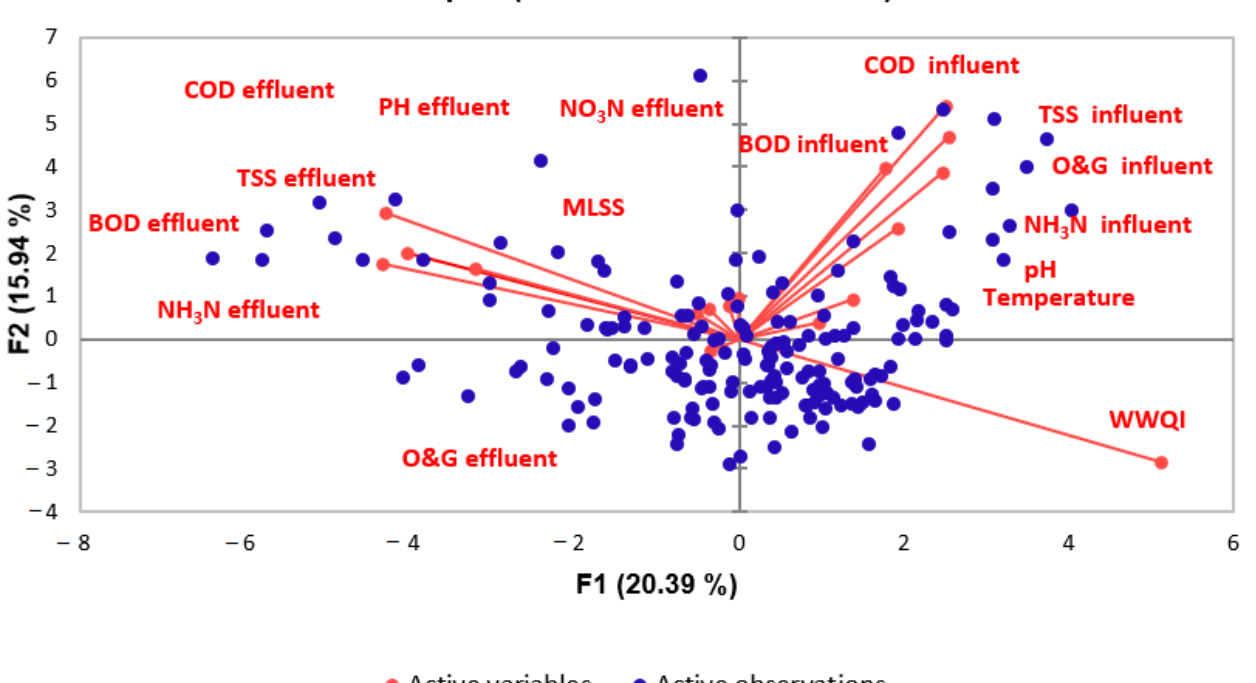
Figure 4. The principal component analysis diagram for the active variables and active observations; PCA 1 for effluent parameters and PCA 2 for influent parameters.